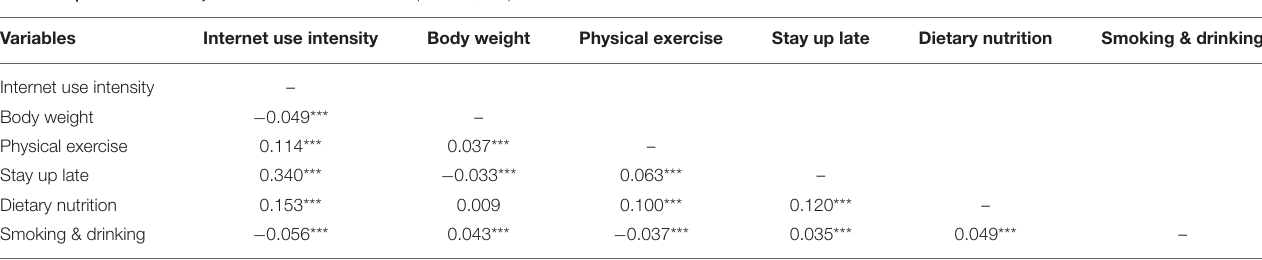
TABLE 2 | Correlation analysis between main variables ( N =